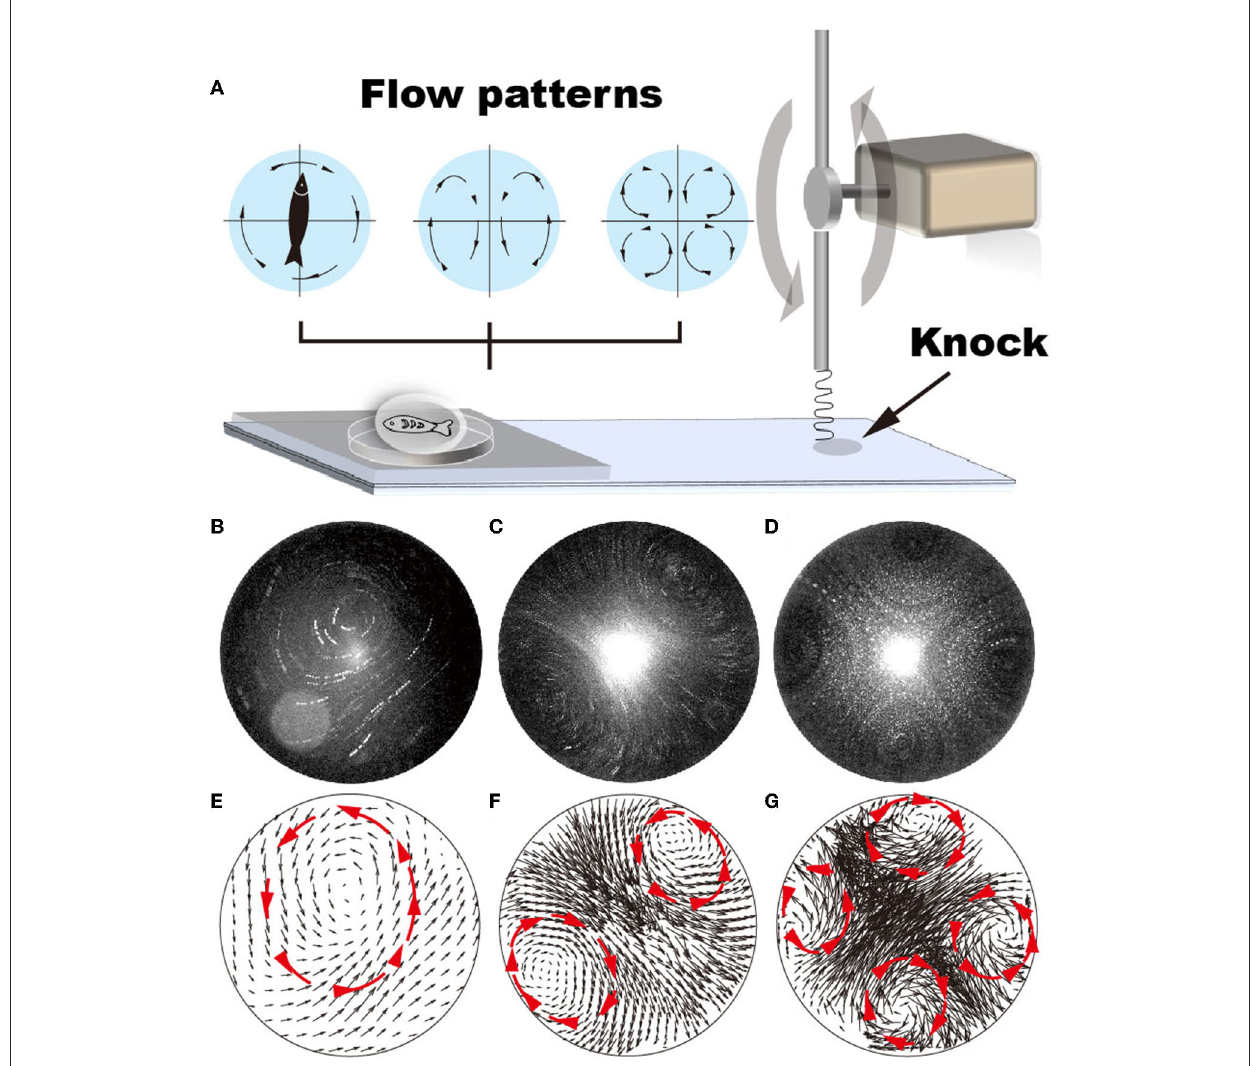
FIGURE1 Various flow patterns can be generated by adjusting the vibration frequency of the glass substrate, i.e., from 22 to 52Hz. (A) Schematic shows that the vibrating frequency is regulated by repeatedly knocking the glass substrate. (B–G) Using GFP fluorescent particles (1 µ m in diameter) as a tracker, flow patterns generated by vibrating the glass substrate at vibrating frequencies ranging from 22 to 52Hz are plotted. (A, D) Single recirculating flow zone generated at 22–35Hz frequency; (B, E) two recirculating flow zones generated at 36–47Hz frequencies; (C, F) four recirculating flow zones generated at 48–53Hz